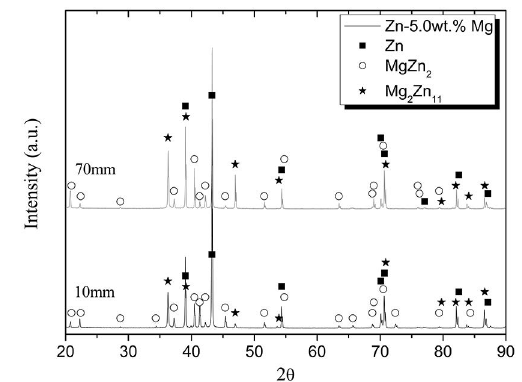
Figure 4. Patterns of X-ray diffraction.